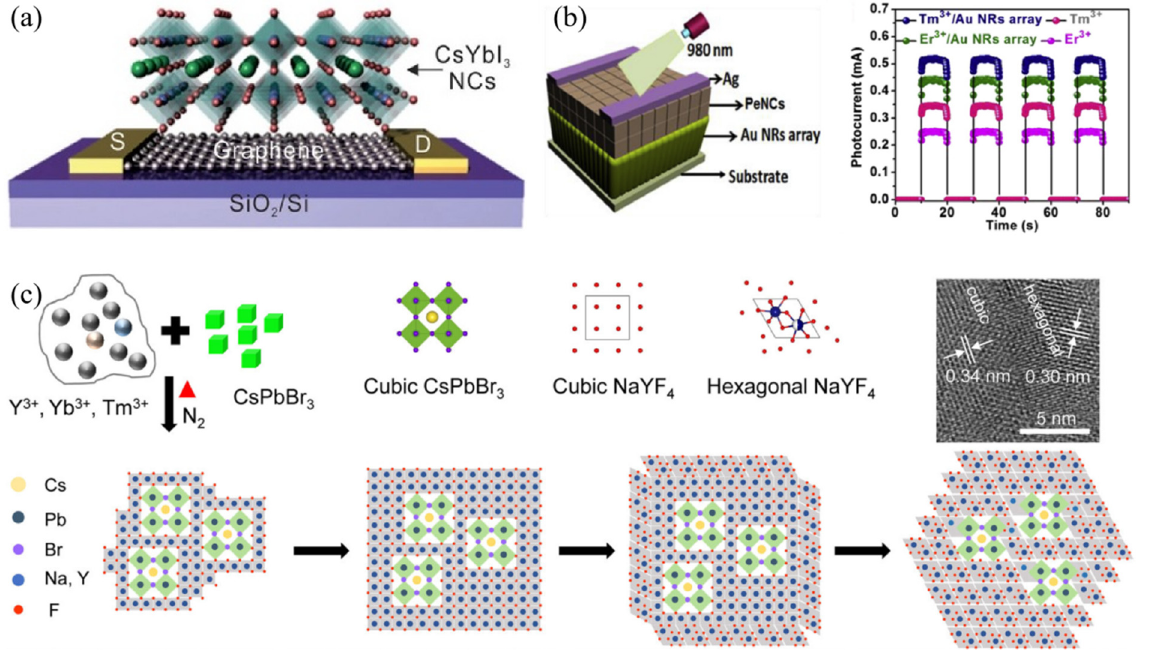
Figure 10. ( a ) Device structure of perovskite photodetector based on CsYbI 3 /Graphene (Re- printed/adapted with permission from Ref. [90]. Copyright 2019 John Wiley and Sons); ( b ) Device configuration and photocurrent of the photodetectors based on CsPbF 3 :Zn 2+ -Yb 3+ -Tm 3+ (or Er 3+ )/Au nanorods (Reprinted/adapted with permission from Ref. [92]. Copyright 2020 Elsevier); ( c ) Sche- matic illustration for the formation of heterostructures CsPbBr 3 -NaYF 4 :Yb and Tm nanocrystals (Re- printed/adapted with permission from Ref. [94]. Copyright 2021 Springer Nature).